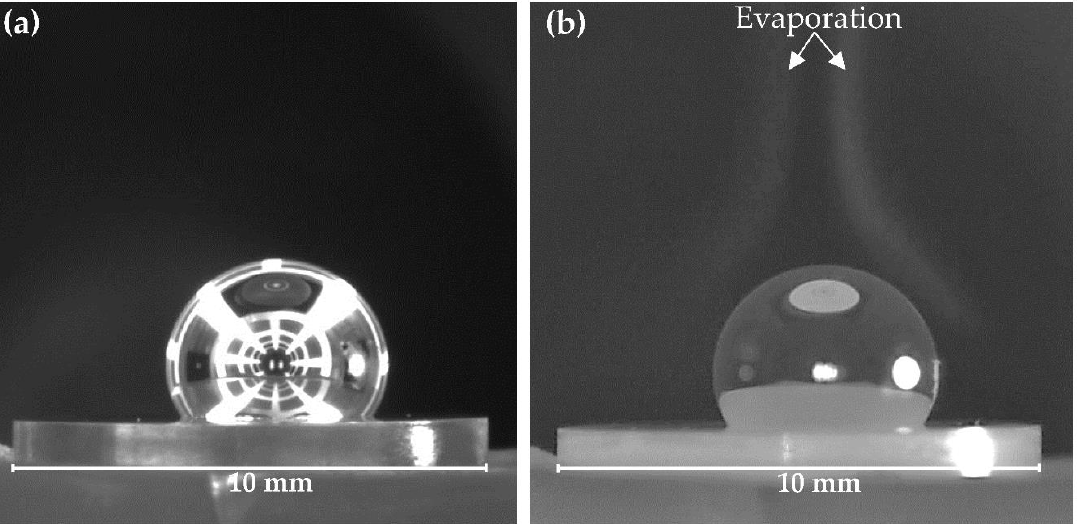
Figure 5. Images recorded with the second CCD camera during the wettability test of Mg/W couple under flowing Ar + 5 wt.% H 2 atmosphere at T = 700 °C: ( a ) after deposition; ( b ) after 180 s, once cooling has begun.